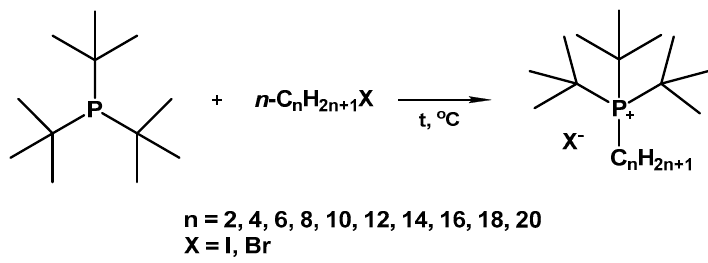
Scheme 2. The anion exchange reaction.